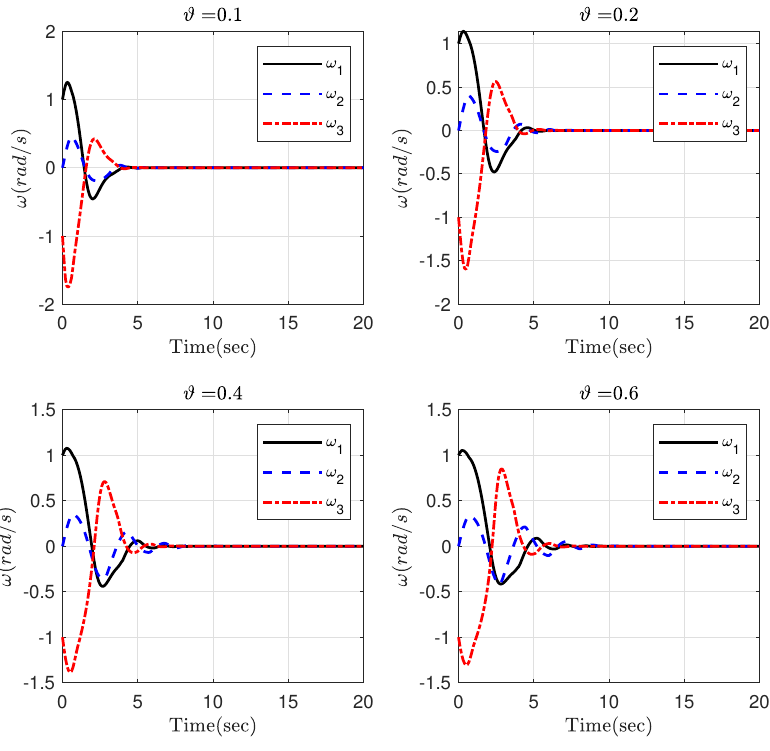
Figure 13. Time responses of the rotation velocity in Part 2 for different ϑ .